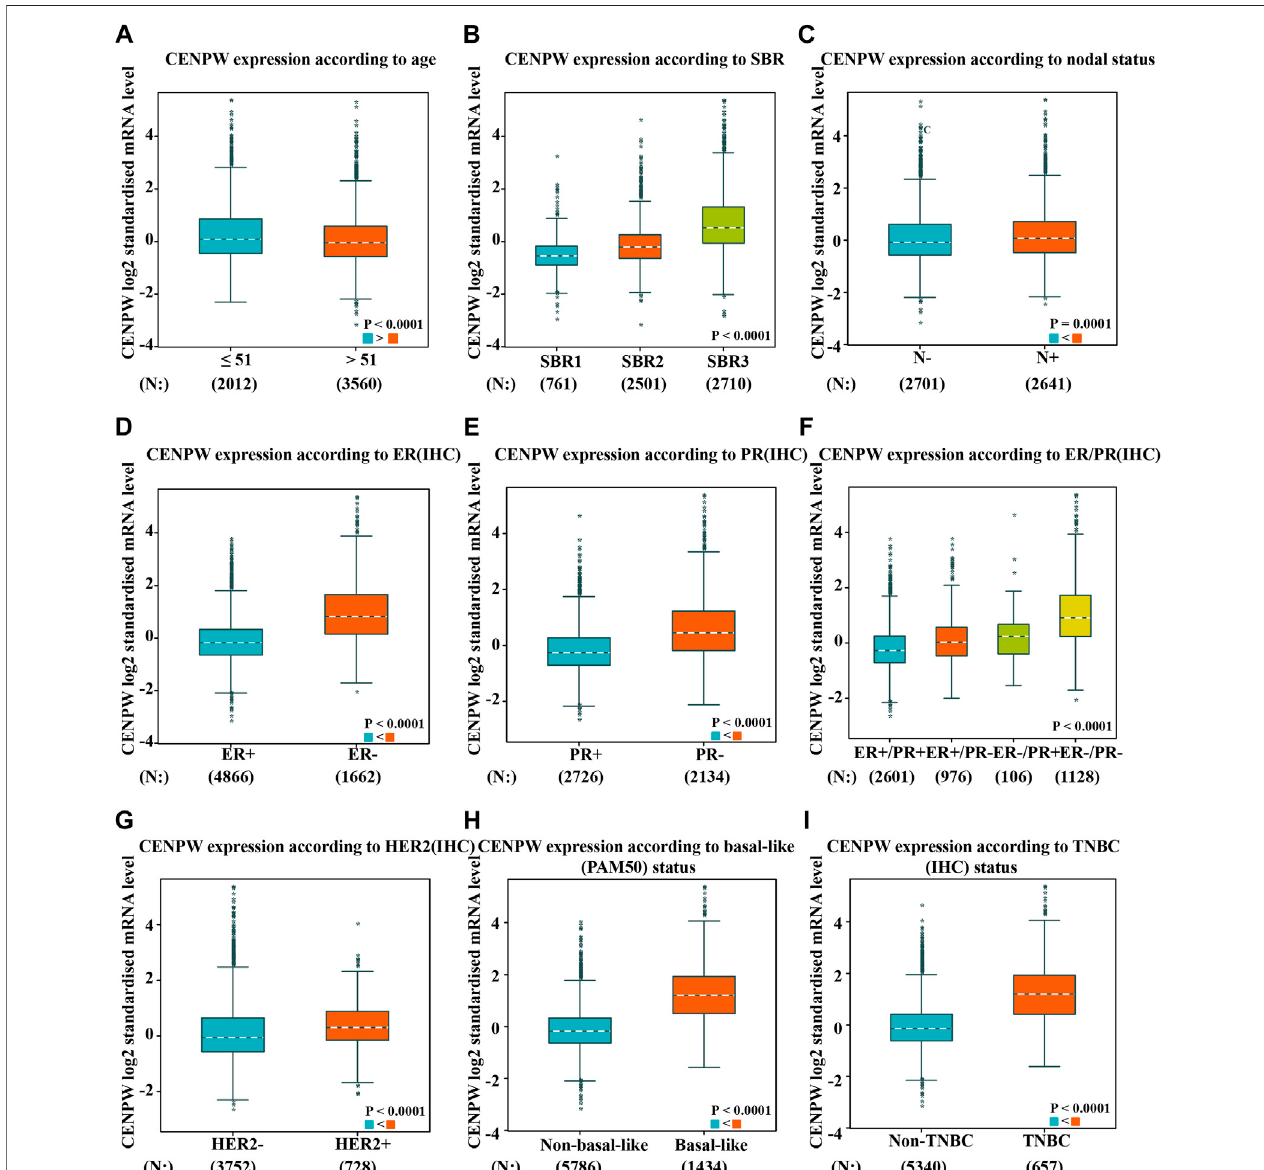
FIGURE3| Thecorrelationbetween CENPW expressionandvariousclinicopathologicalparameters.Dataaredisplayedfor (A) age, (B) SBR, (C) nodalstatus, (D) ER, (E) PR, (F) ER/PR, (G) HER-2, (H) basal-like status and (I) triple-negative status.